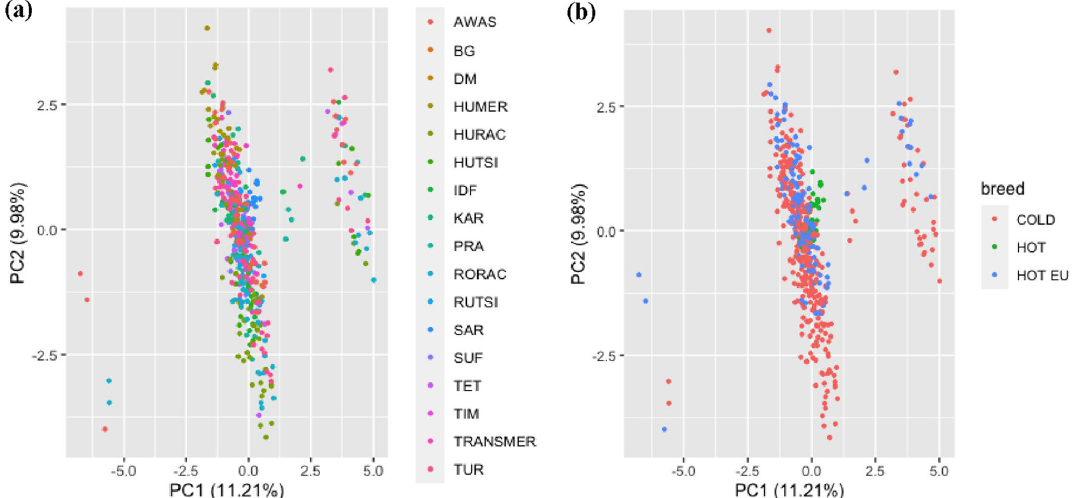
Figure 1. Score biplot of Principal Component Analysis of the 17 SNPs and 601 animals. ( a ) Individuals of different breeds are differently colored; ( AWAS Hungarian Awassi, BG Béni Guil, DM D’Man, HUMER